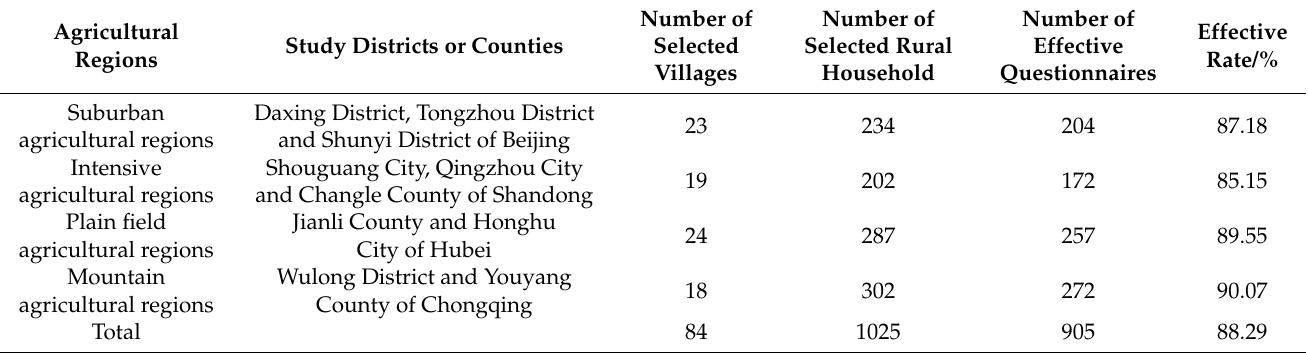
Table 1. Description of the survey of rural households in the study